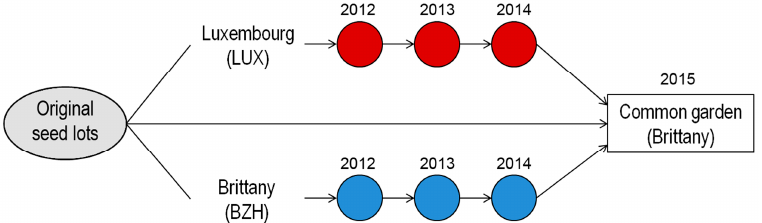
Figure 6. Schematic representation of the multiplication stages carried out for the development of the different bean populations assessed. different bean populations